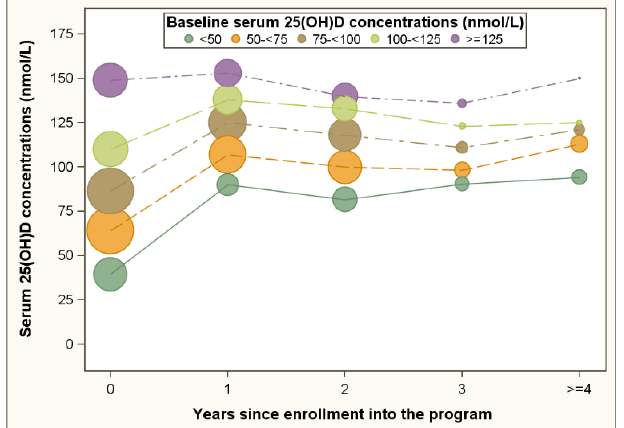
Figure 1. Serum 25(OH)D concentrations of program participants during follow up and grouped by baseline 25(OH)D concentrations. 25(OH)D, 25-hydroxyvitamin D; the sizes of the bubbles are proportional to the numbers of participants.